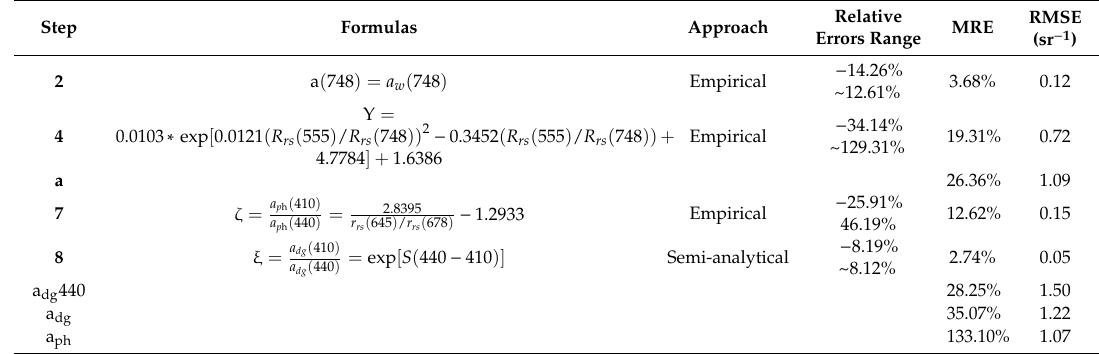
Table 8. Error propagation of steps of the improved QAA.